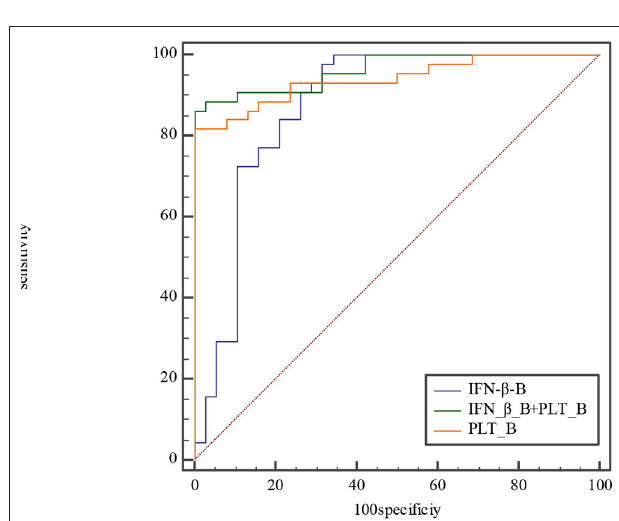
FIGURE 6 | Comparison of ROC curve at subacute phase between IFN- β , PLT, and combined IFN- β and PLT. The AUC of IFN- β , PLT, and combined IFN- β and PLT is 0.876, 0.941, and 0.964, with 0.785–0.939, 0.866–0.981, 0.897–0.992 for their 95% CI separately. The difference of AUC between IFN- β and PLT is about 0.06, Z ≈ 1.28, P ≈ 0.20. The difference of AUC between IFN- β and combined IFN- β and PLT is about 0.09, Z ≈ 2.1, P ≈ 0.04. The difference of AUC between PLT and combined IFN- β and PLT is about 0.02, Z ≈ 1.89, P ≈